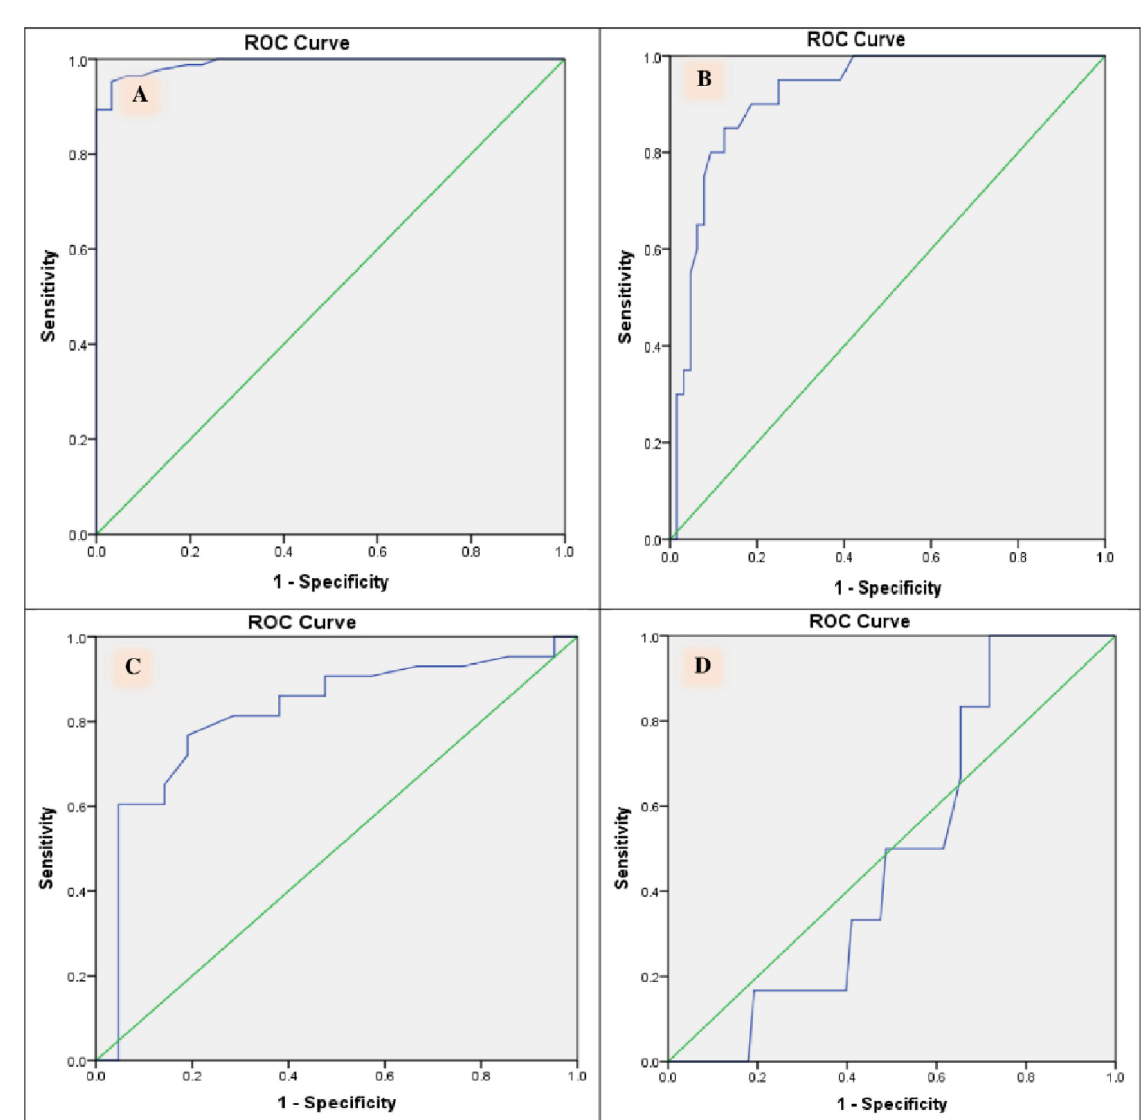
Fig 1. ROC curve for 25(OH)D in (A) bladder cancer patients vs. controls, (B) non-muscle invasive bladder cancer vs. Muscle invasive bladder cancer, (C) low-grade cancer vs. high-grade bladder cancer and (D) recurring bladder cancer vs non-recurrent bladder cancer.